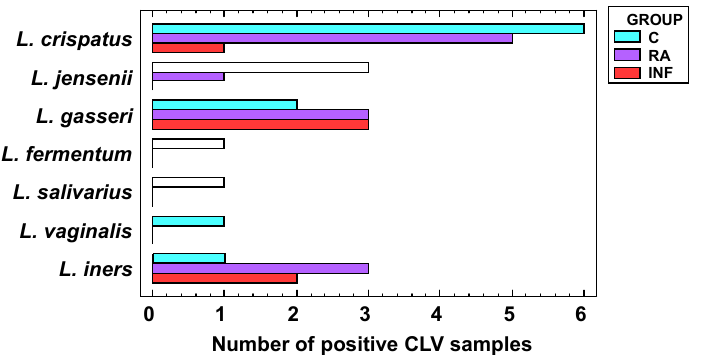
Figure 1. Dominant lactobacilli species (when lactobacilli could be isolated) in cervovaginal lavage (CVL) samples of fertile women (C, bluish green), women with repetitive abortion (RA, purple) and women with infertility of unknown origin (INF, red).